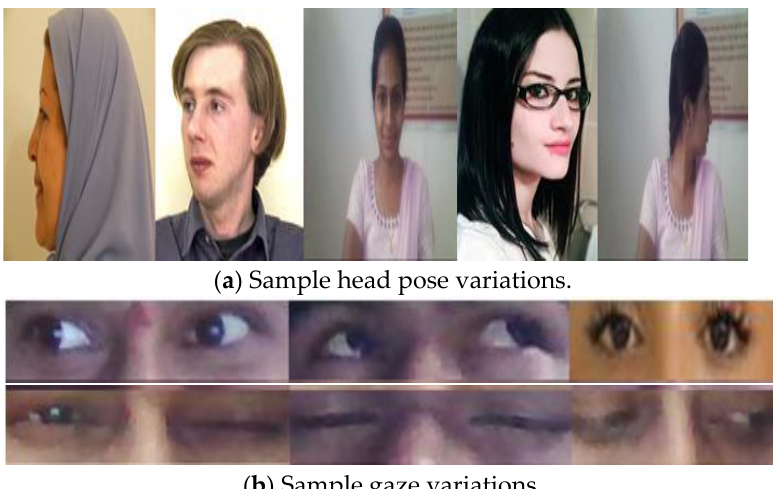
Figure 2. Sample head pose and gaze images.